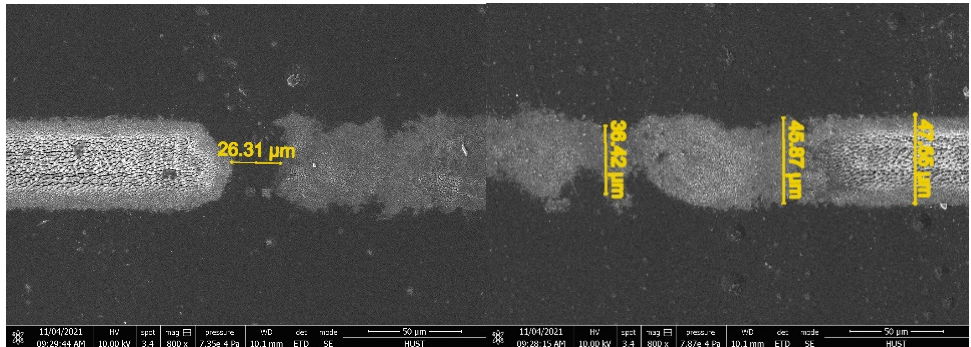
Figure 10. Defects of microchannel under 5.6 mol/L phosphoric acid solution.